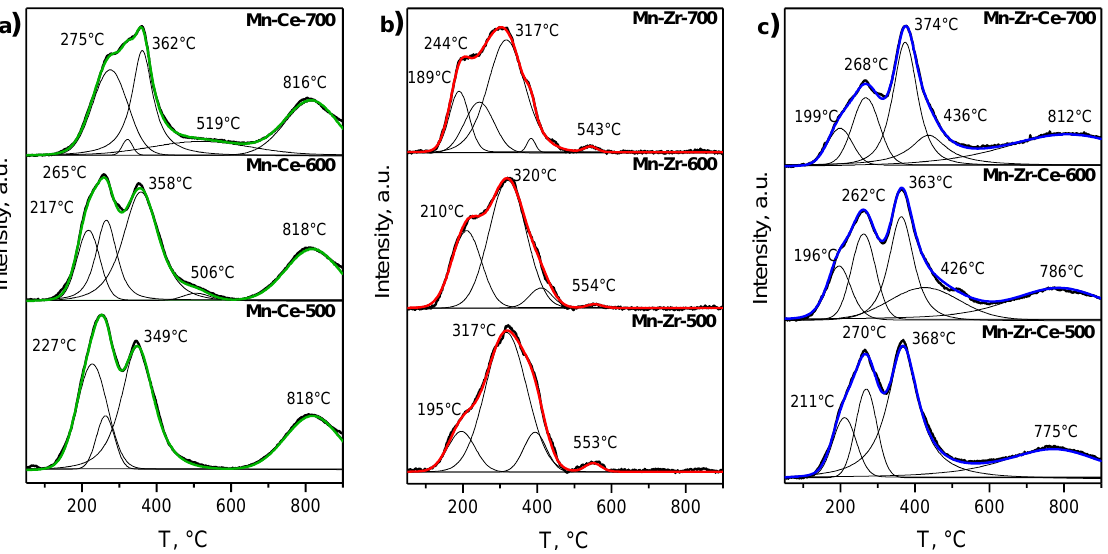
Figure 4. TPR-H 2 curves for ( a ) Mn-Ce, ( b ) Mn-Zr and ( c ) Mn-Zr-Ce catalysts, calcined at 500, 600 and 700 °C. Diferent colours corresponds to different series.